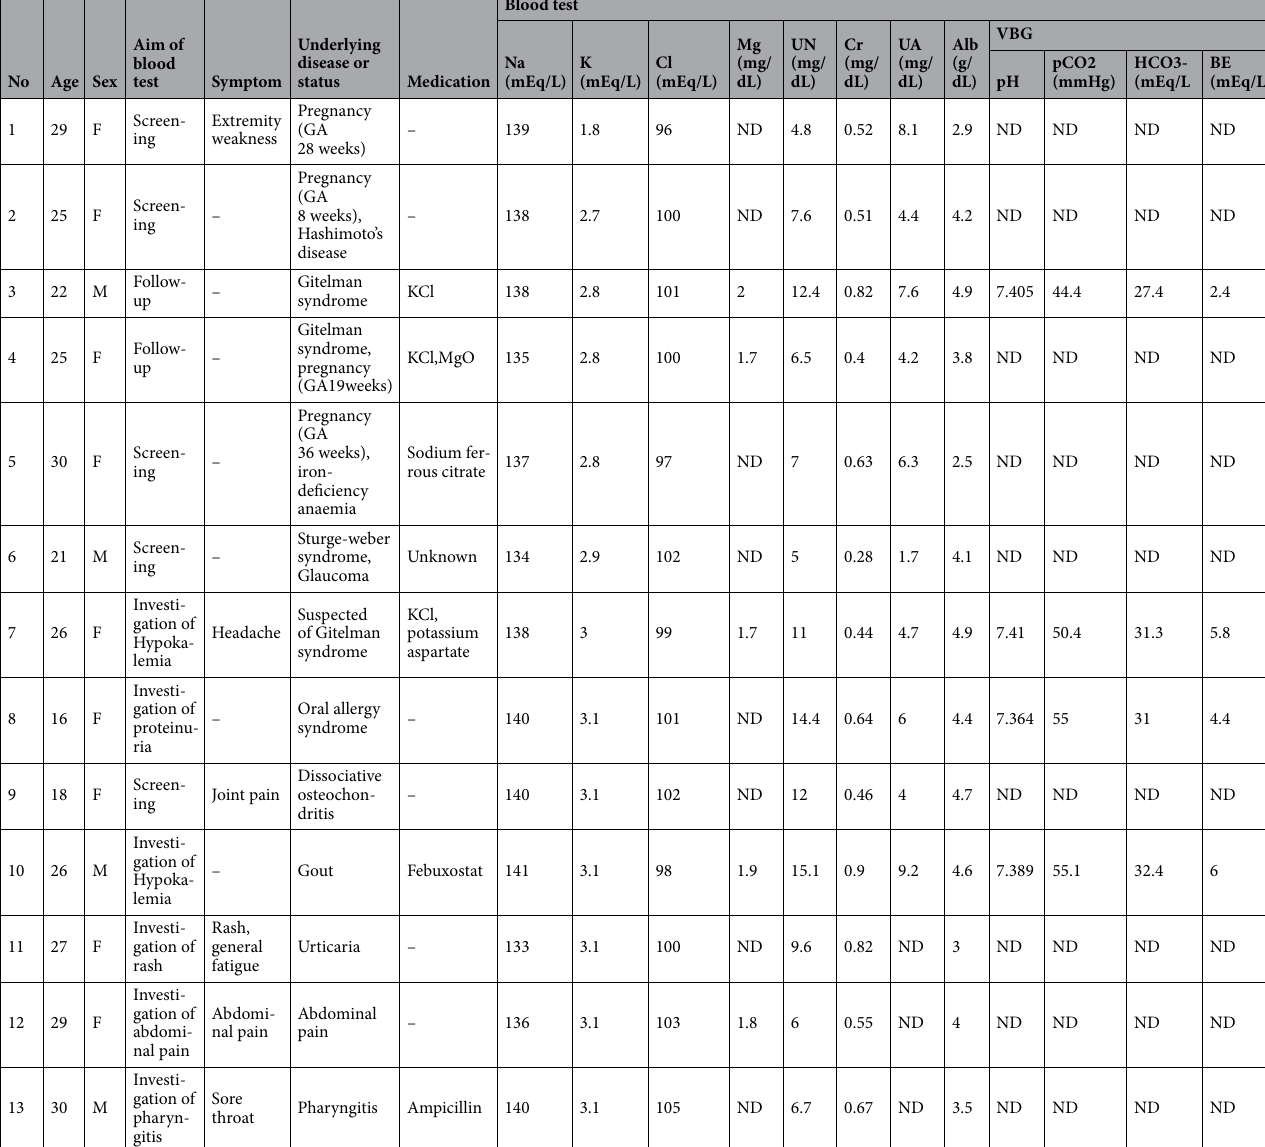
Table 3. Characteristics and blood test results of patients who showed hypokalemia with no apparent cause other than GS. GA gestational age, ND no data, UN urea nitrogen, Cr creatinine, UA uric acid, Alb albumin, VBG venous blood gas, BE base